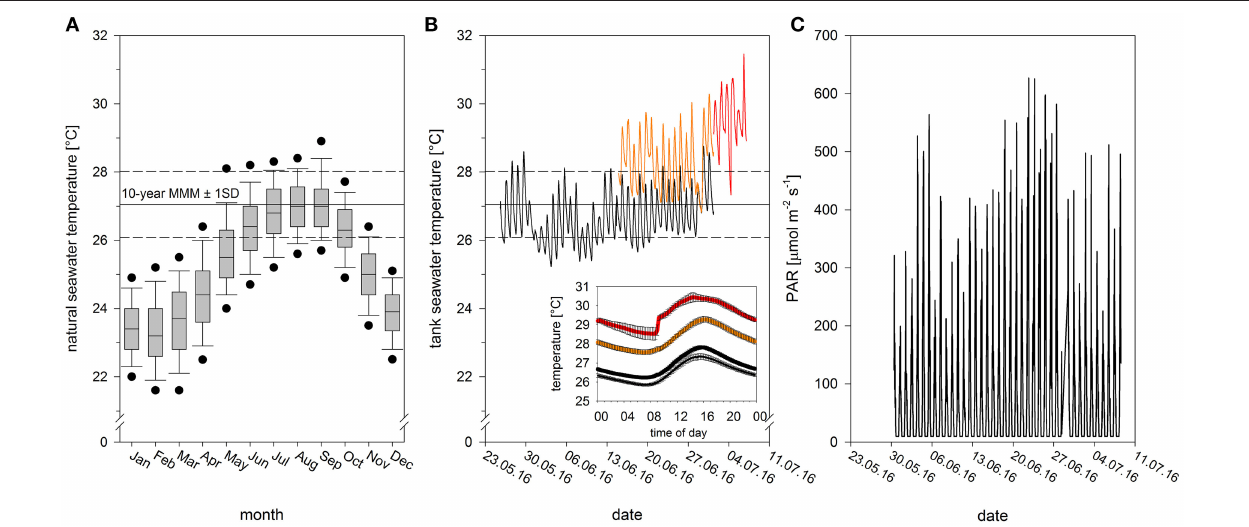
FIGURE 1 | Abiotic conditions during recovery, acclimation and heat stress. (A) Monthly seawater temperature range for a representative shallow coral reef location in Kaneohe Bay between 2006 and 2015 (data derived from automatic weather station of PacIOOS at HIMB, Point Lab, from ∼ 1m water depth). The maximum monthly mean is reached in September with the current 10-year MMM at 27.05 ± 0.97 ◦ C (mean ± SD, 2006–2015, N = 7,200). Black dots in boxplots show the 5th and 95th percentiles. (B) Experimental thermal profile with initial tank acclimation (black thin line), temperature acclimation to ambient (black thick line) and elevated temperature (orange), and heat phase (red). Values for tank and temperature acclimation phase are mean values of two tanks. Graph inset shows daily temperature variation (mean ± SE) during the respective experimental phases (cf. Figure S1 for daily natural variation). (C) Photosynthetically active radiation (PAR) over the course of the experiment, monitored using underwater Odyssey light